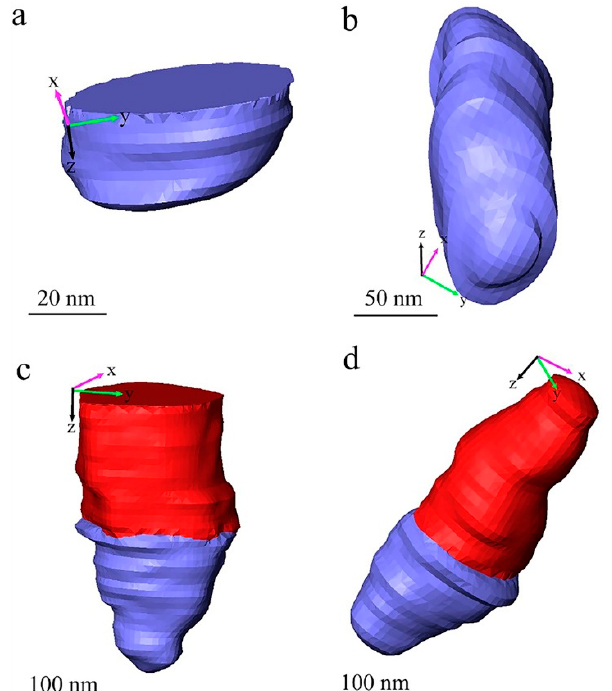
Figure 5. 3D rendering of natural voids and voids produced by particle shedding in the TiO 2 pigmented waterborne paint: ( a ) An incomplete natural void near the surface of the paint film; ( b ) An intact natural void inside the paint film; ( c ) A void produced by particle shedding connected to a TiO 2 particle near the surface of the paint film; ( d ) Another void produced by particle shedding connected to a TiO 2 particle inside the paint film. The red parts are TiO 2 particles and the blue parts are